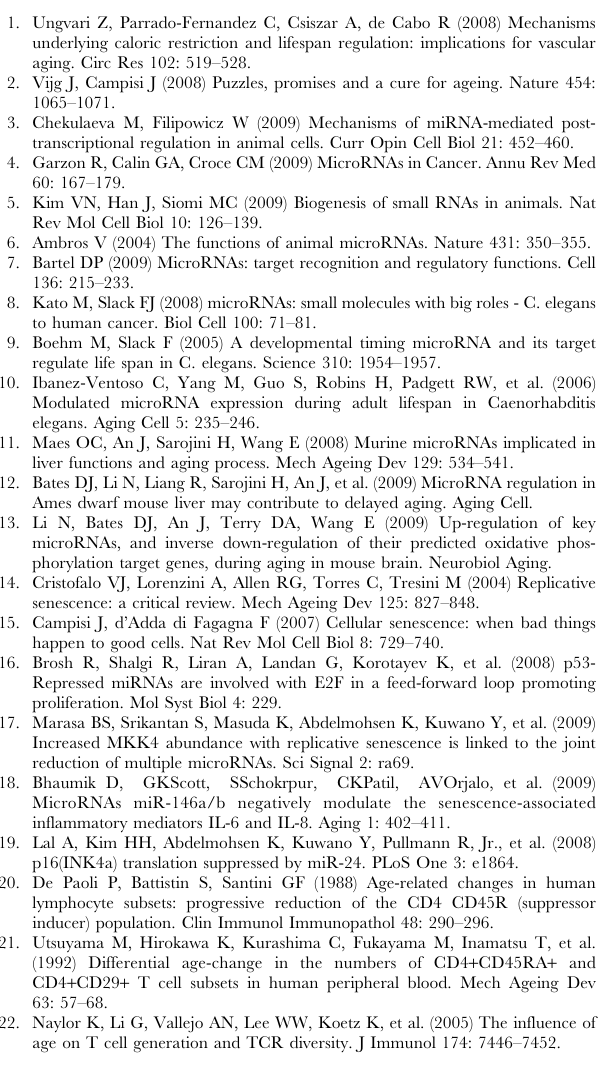
Figure S2 Lymphocyte marker expression in participant PBMCs. CD4, CD8 and IL-7 receptor expression was examined in young and old individuals using RT-qPCR and normalized to the average of HPRT and UBC. The ratio of CD4/CD8 expression is also shown. The indicated P values show the significance of each parameter between young and old individuals using Student’s